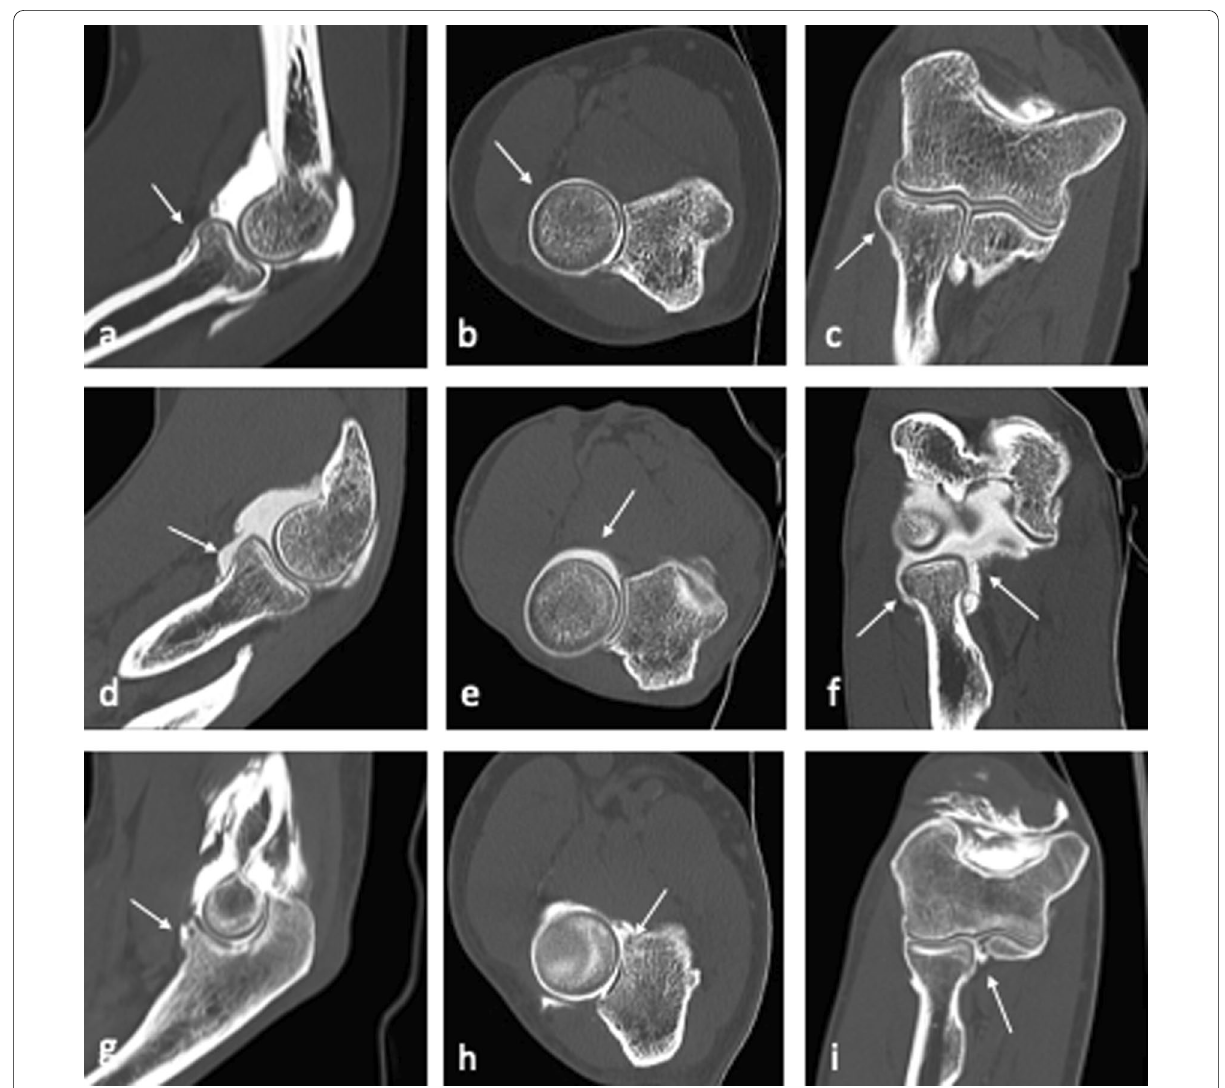
Fig. 12 CT-arthrography sagittal ( a , d , g ), axial ( b , e , h ) and coronal ( c , f , i ) images belonging to three patients, two of which display different SMILE stages involving the AL (white arrows). Intact annular ligament (AL) of the lateral collateral ligament (LCL) complex ( a – c ). Loose AL with no evidence of fiber tearing, displaying the “loose collar sign”, suggestive of patholaxity ( d – f ). Thickened and irregular AL showing a partial-thickness tear ( g – i ); ligament fibers appear delaminated as iodinated contrast permeates through their